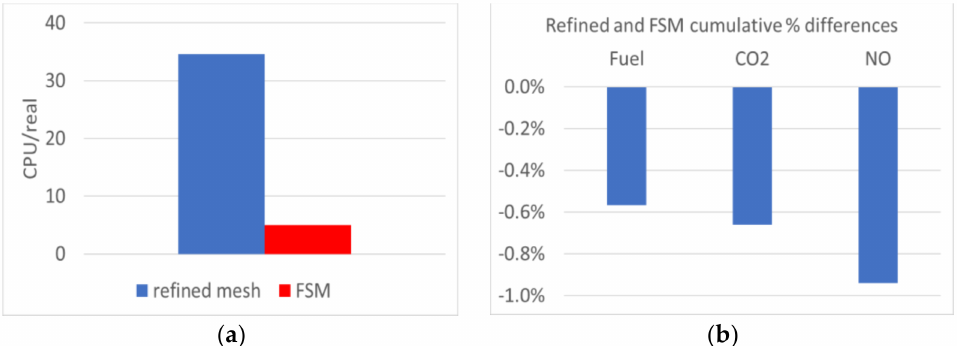
Figure 16. ( a ) Comparison between CPU time/real time of the driving cycle simulated by means of both refined mesh (1 cm) and coarse mesh (10 cm, FSM); ( b ) difference in the prediction of cumulative emissions of the engine emissions between the refined mesh case and